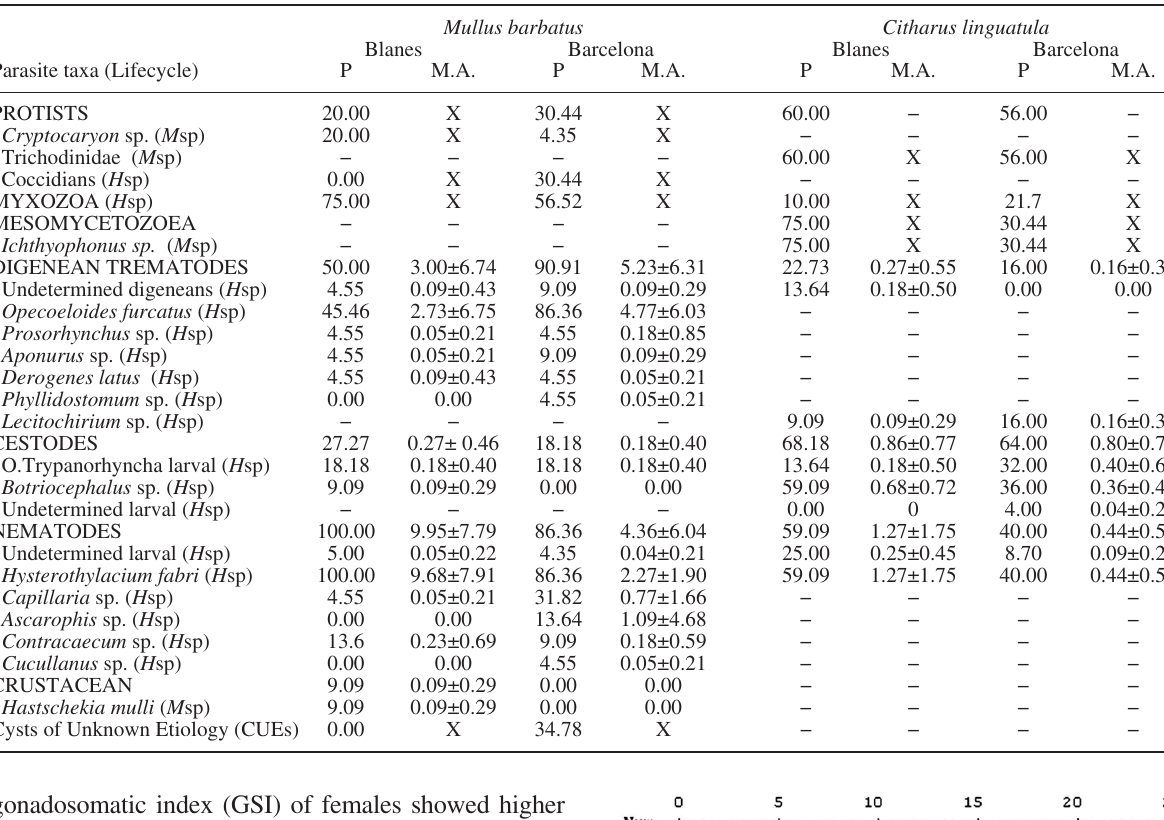
Table 2. – Prevalence (P) and mean abundance (M.A.) of the parasites and pathologies found in Mullus barbatus and Citharus linguatula collected in Blanes and Barcelona. Msp: monoxenous lifecycle, Hsp: heteroxenous cycle, X: no available data, -: parasite species not present in the sample. Protists, Myxozoa, Mesomycetozoea and CUEs were identified by histological methods.